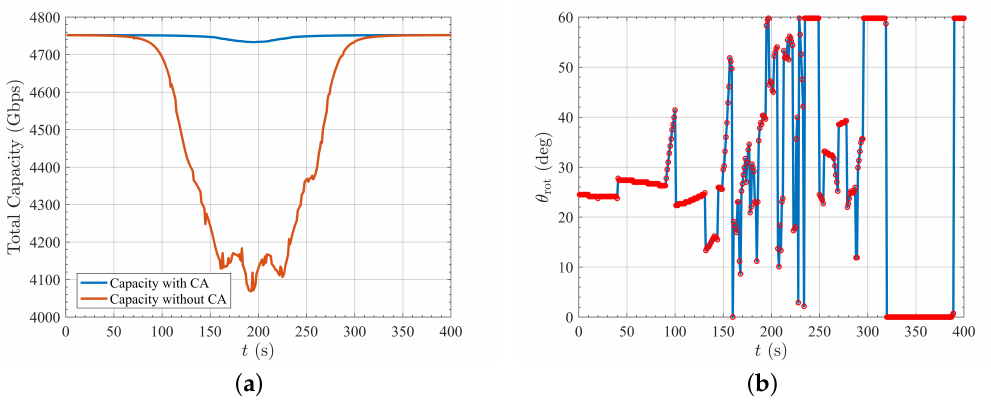
Figure 12. Change of total capacity with and without channel allocation and variation of rotation angle for the 19-beam scenario. ( a ) Change of total capacity with and without channel allocation for the 19-beam scenario; ( b ) Variation of rotation angle for the 19-beam scenario.